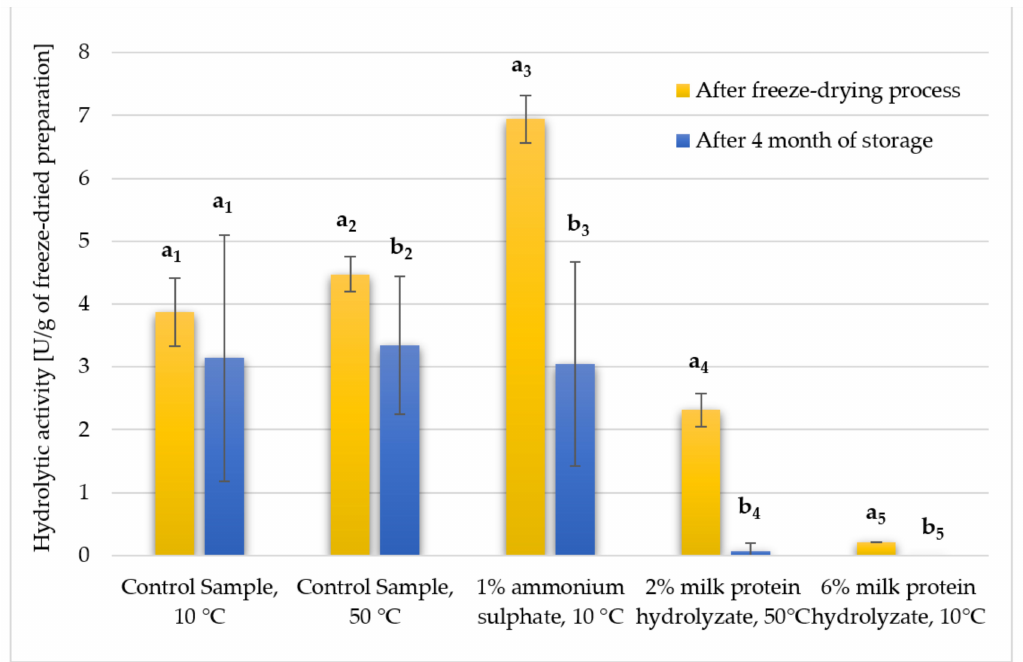
Figure 7. Hydrolytic activity of selected freeze-dried enzyme preparations after storage in a desiccator for 4 months (calculated per 1 g of the final preparation taking into account the presence of both the lyophilized supernatant and the addition of cryoprotectant). Significant differences are marked with letters and a number given in a subscript indicate the compared values. Experiments were performed in